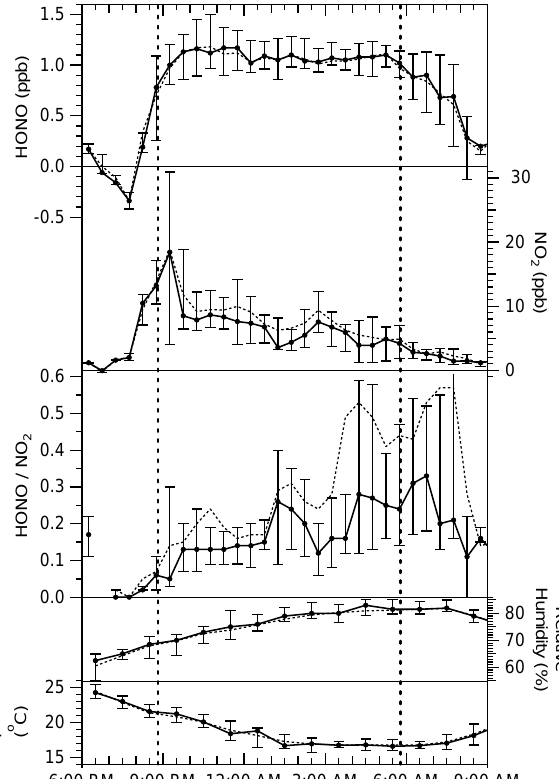
Fig. 6. Study average nocturnal profiles, 24 July–9 August 2005. Shown are median ( • ), 25-th and 75-th percentiles (error bars), and average value (dotted line) within each 30min bin. Vertical dashed lines represent times of sunset and